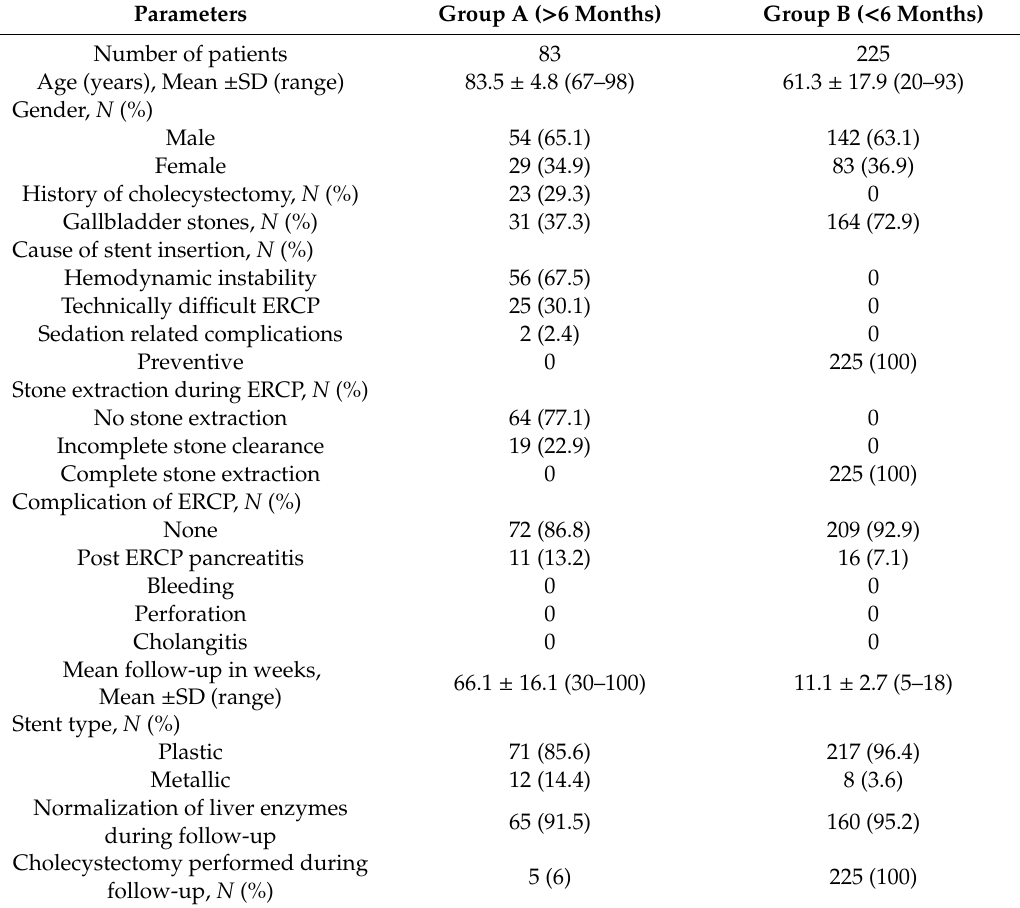
Figure 1. Demonstrating the flow chart of our study cohort. Table 1. Demographics and endoscopic characteristics of study cohort.